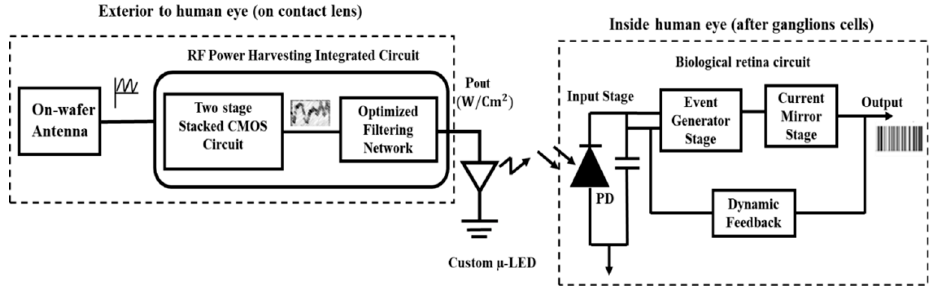
Figure 2. Proposed block diagram at the interface between wireless power devices and CMOS neuron IC.